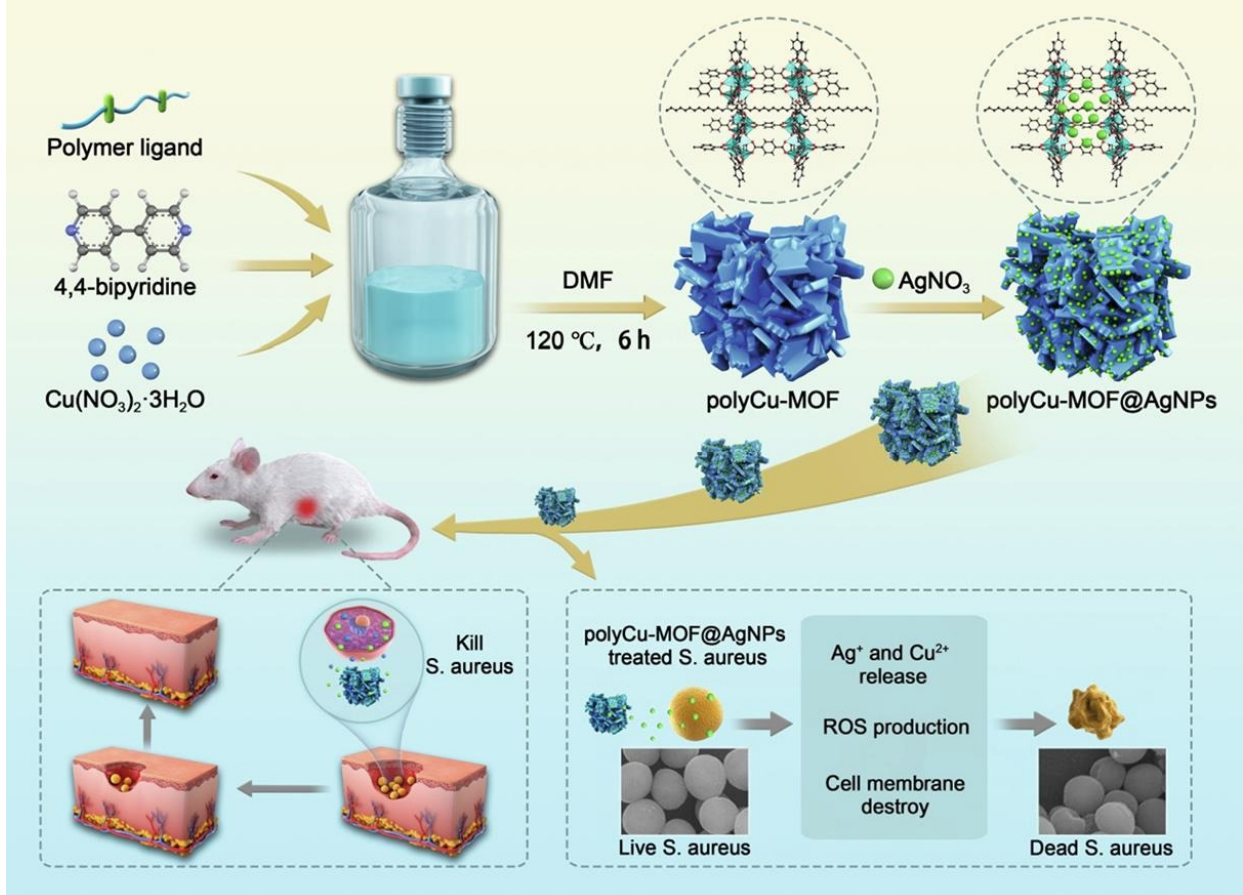
Figure 7. Schematic of the synthesis procedure and the antibacterial and wound healing activities of the poly Cu-MOF@ Ag hybrid. Reproduced with permission from [125].